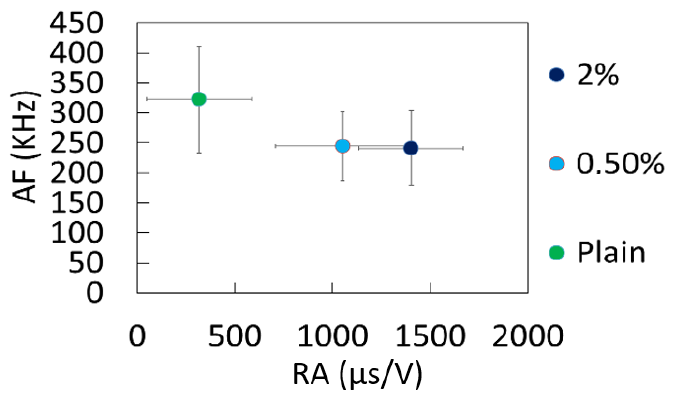
Figure 9. Correlation plot between average frequency (AF) and RA for different steel fiber content. The error bars correspond to the standard deviation.